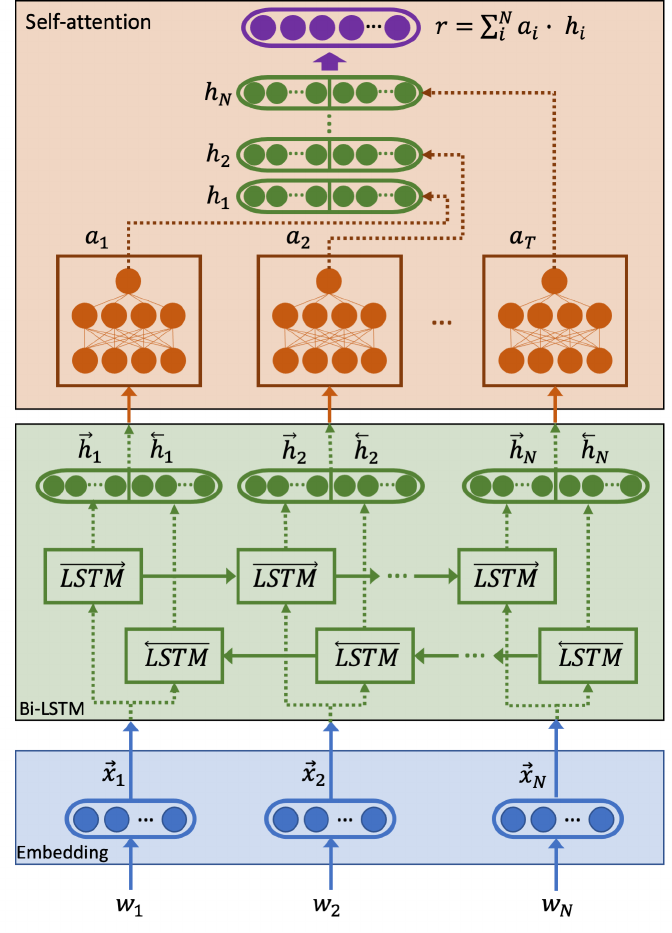
Figure 2. Proposed Recurrent Neural Network (RNN) model (figure directly taken from